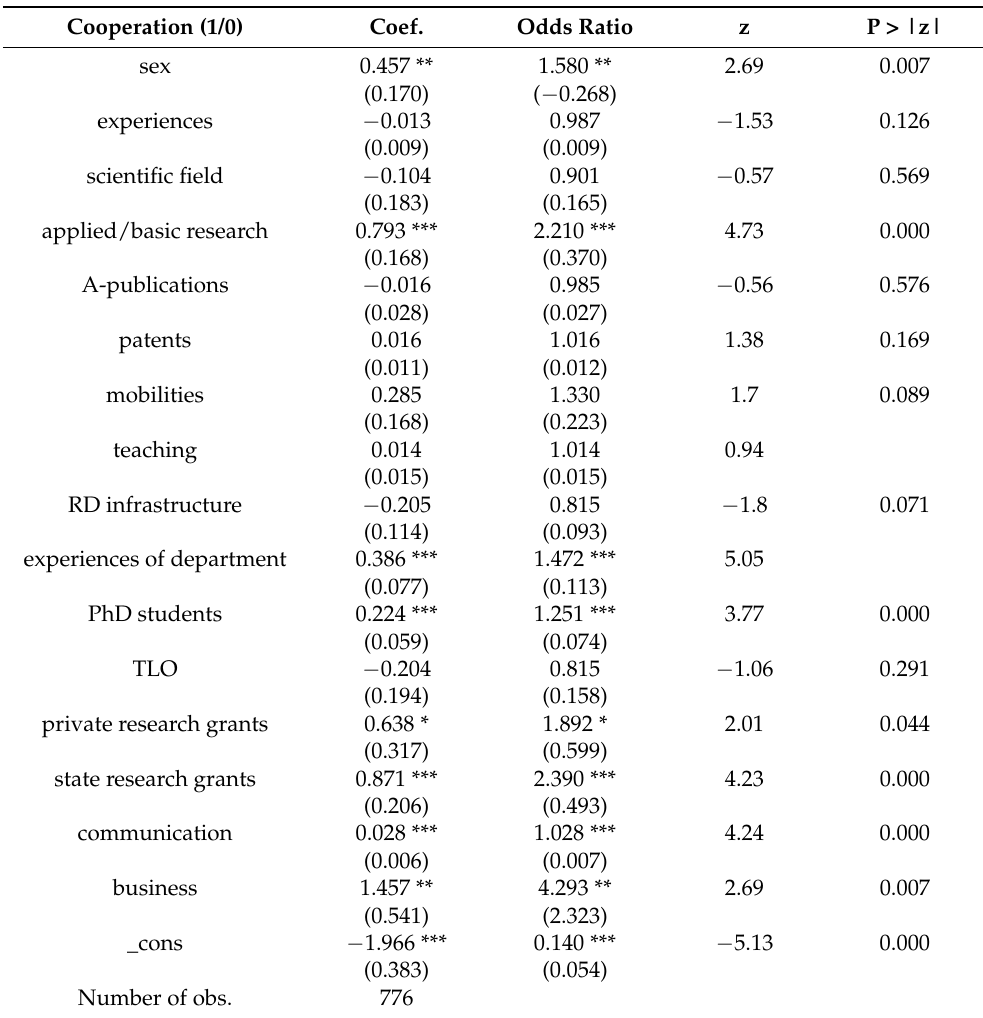
Table 6. Results of the